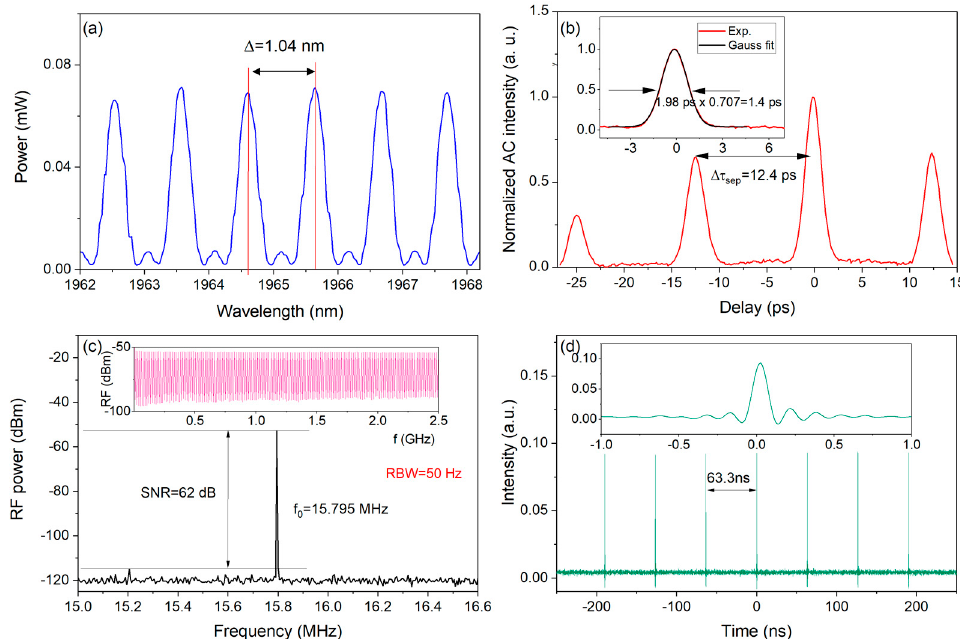
Figure 3. Output characteristics of the bound-state soliton generation mode: ( a ) part of the output spectrum of bound solitons spanning from 1962 to 1968 nm; ( b ) autocorrelation trace ( c ) radio-frequency spectrum with scanning ranges of 1.6 MHz and 2.5 GHz (inset), and ( d ) oscilloscope trace of the mode-locked pulse train (inset: single pulse).